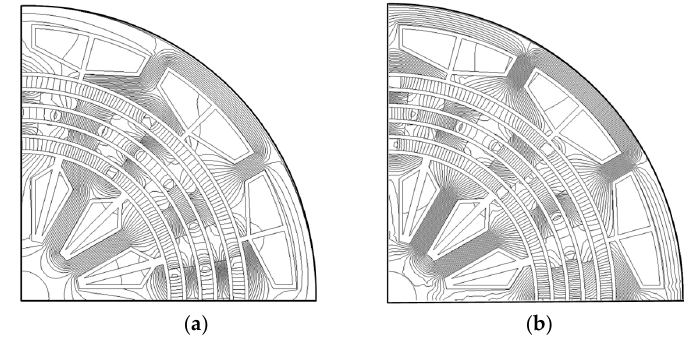
Figure 9. Magnetic flux lines distribution: ( a ) Without load; ( b ) With load.